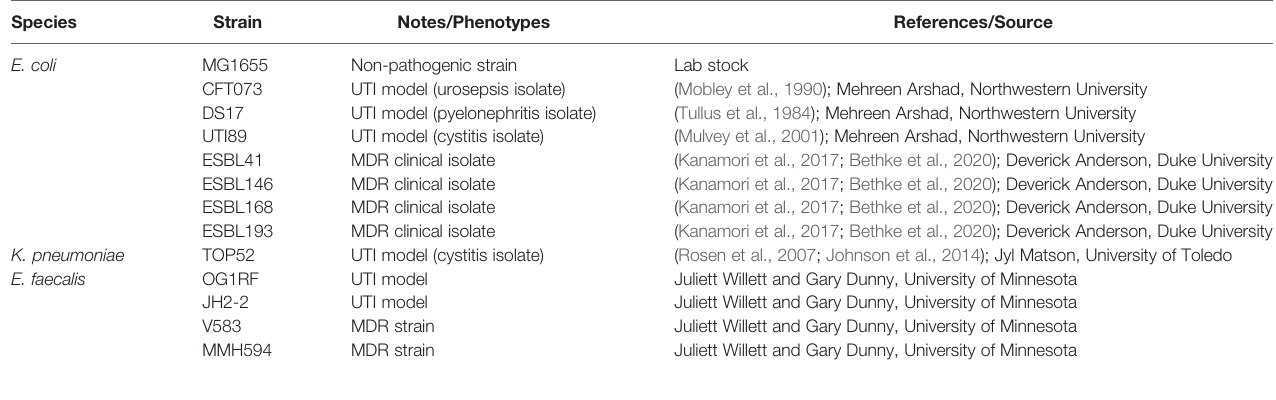
TABLE 2 | Strains of uropathogen species used in this study. Species